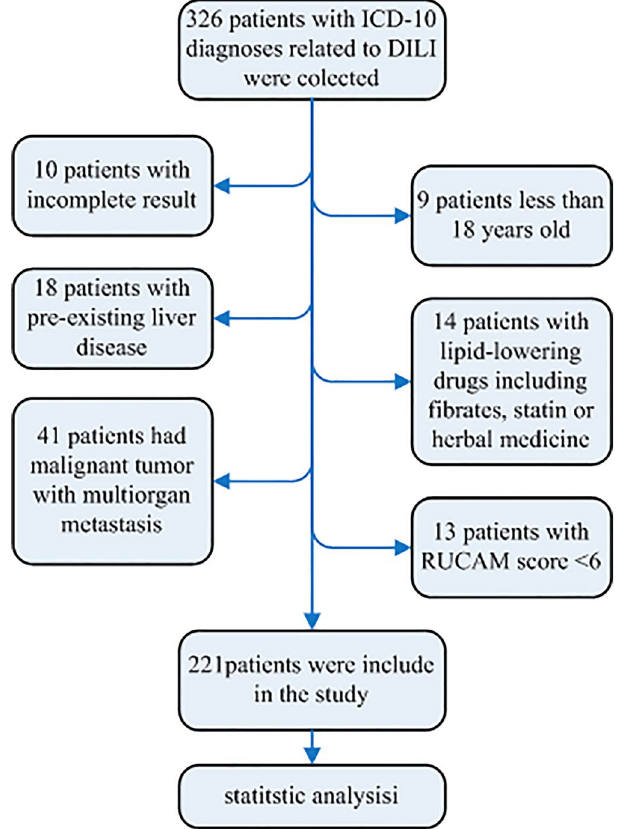
Figure 1. Flow chart of the